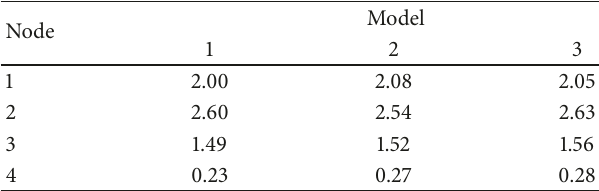
Table 4: Maximum displacements (mm) of models 1 to